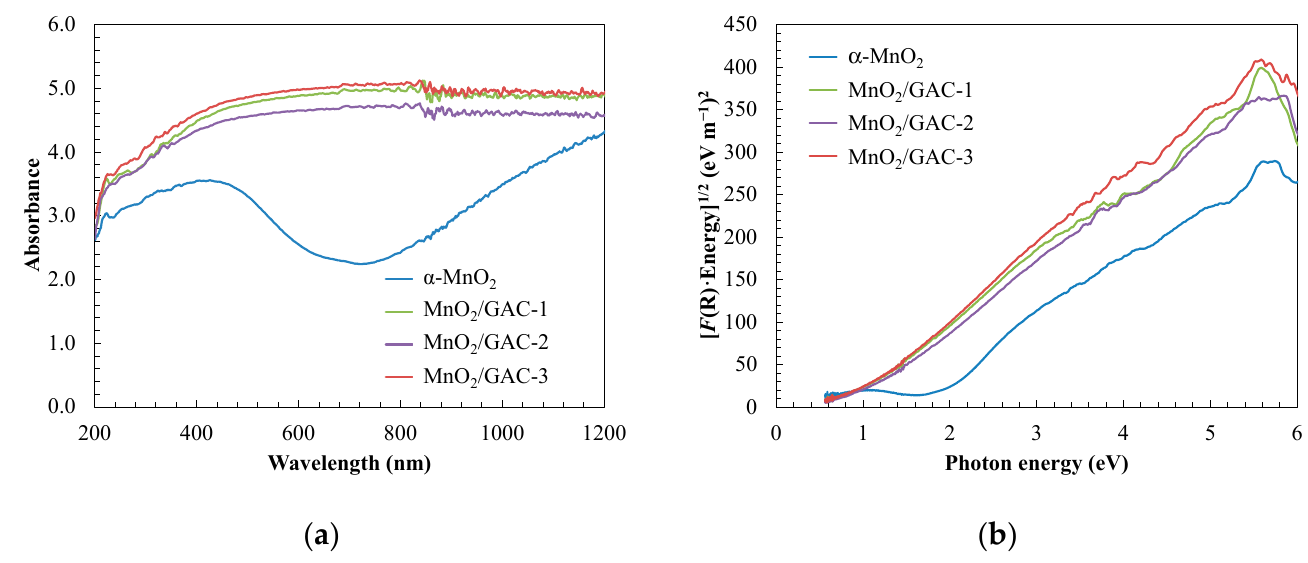
Figure 7. UV–Vis absorption spectra ( a ) and determination of the band gap values of the new catalysts ( b ). The band gap was determined using the Tauc plot (Figure 7b) and the transformed Kubelka–Munk function [71,73]: